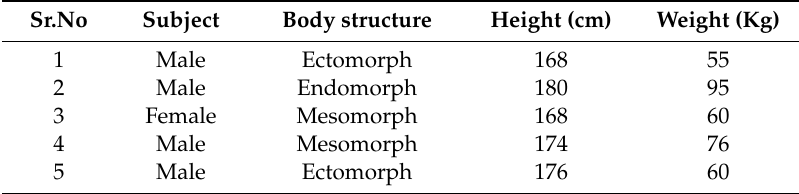
Table 4. Subject participation in experiments.